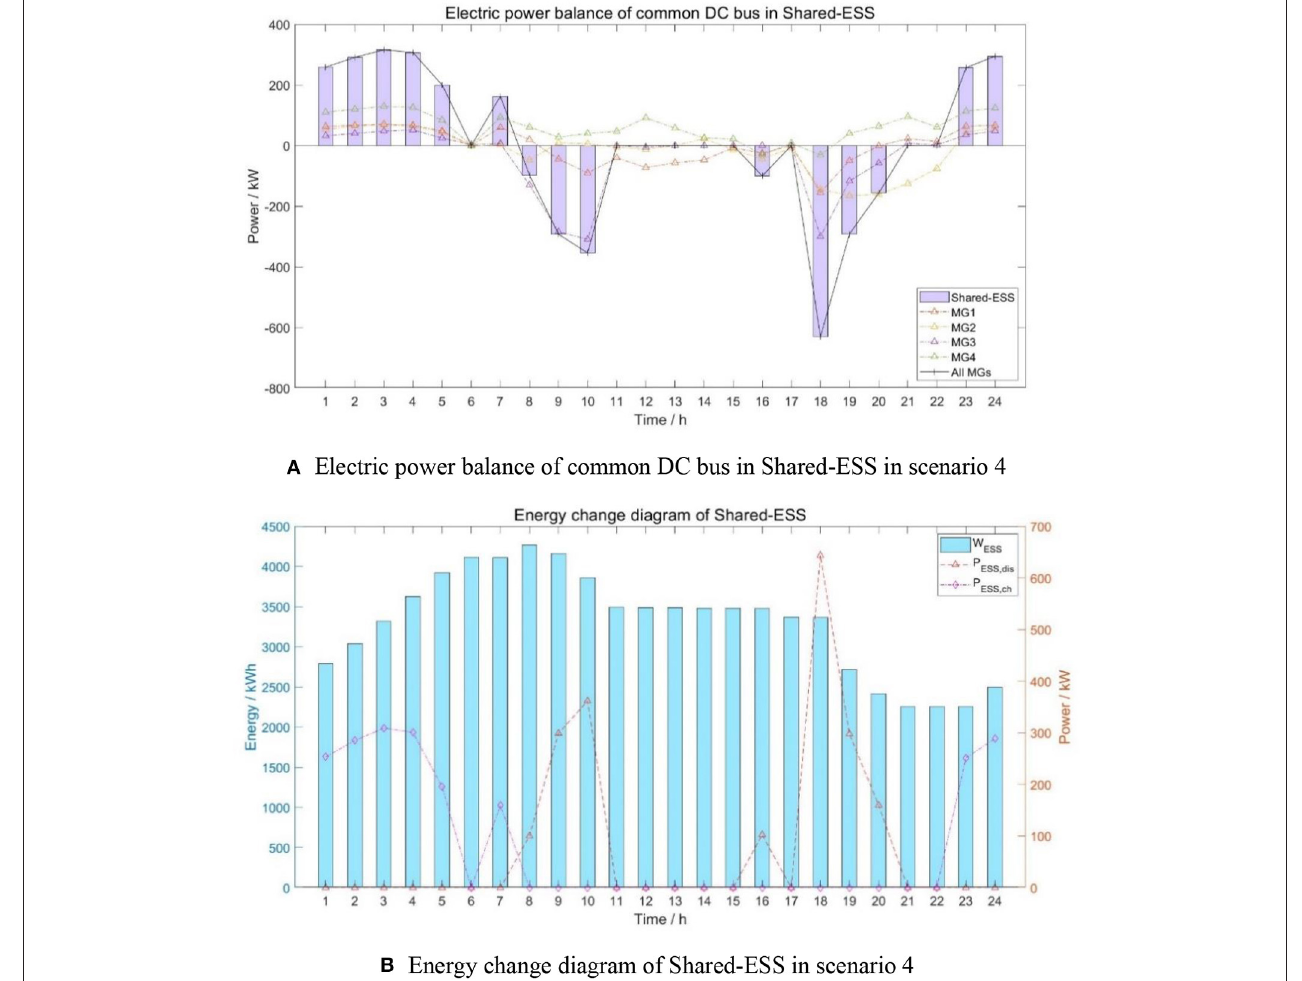
FIGURE 8 | The operating status of Shared-ESS in scenario 4. (A) Electric power balance of common DC bus in Shared-ESS in scenario 4. (B) Energy change diagram of Shared-ESS in scenario 4.